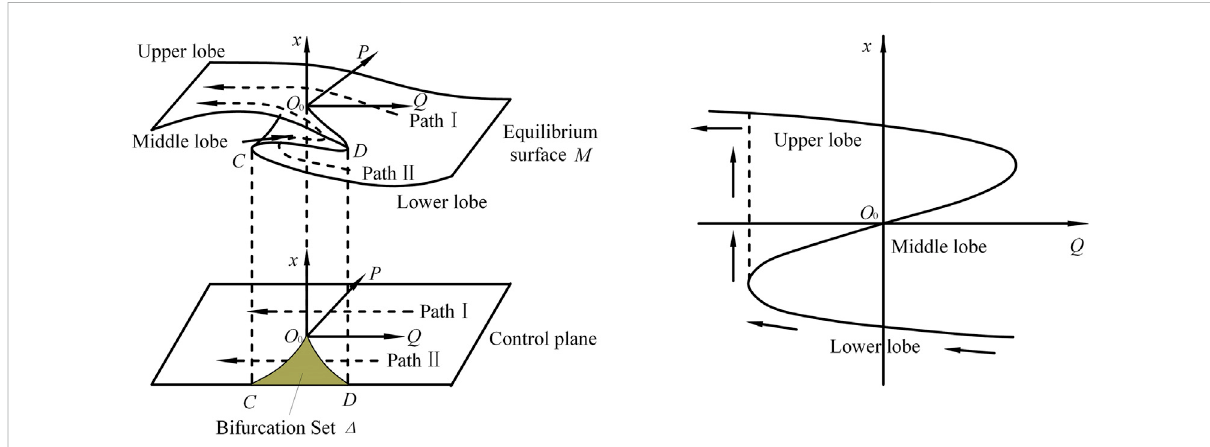
FIGURE 6 Equilibrium surface and control plane of the